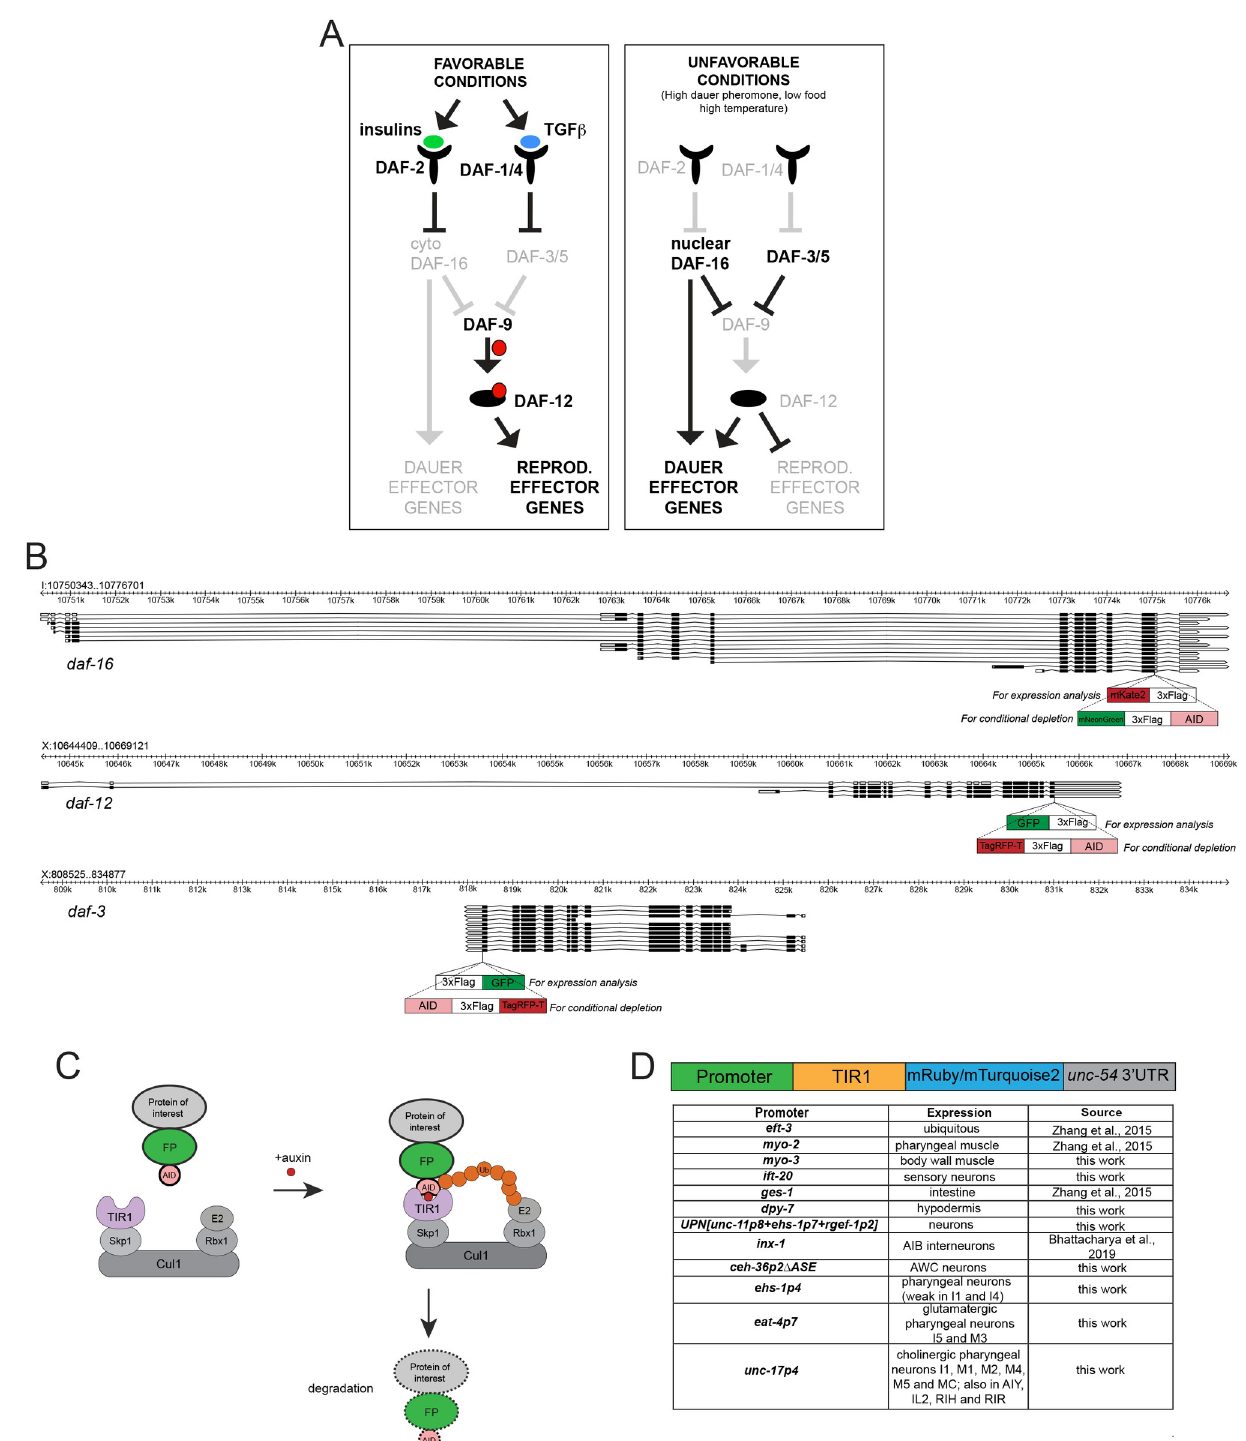
Fig 1. Reagents generated for this study. ( A ) Much simplified overview of the dauer pathways, with DAF-3/SMAD, DAF-16/FoxO, and DAF-12/VDR as transcriptional effectors [25]. ( B ) Genomic loci of daf-16 , daf-12 , and daf-3 . The insertions sites and schematics of the expression reporters and of the AID tag are shown. ( C ) Schematic of the AID system. Skp1, Cul1, Rbx1, and E2 are phylogenetically conserved components of the E3 ligase complex. TIR1 is a plant-specific substrate-recognizing subunit of the E3 ligase complex. AID, fused to a protein of interest, is bound by TIR1 in the presence of auxin, which leads to ubiquitination and proteasomal degradation of the protein of interest. ( D ) Summary of TIR1 transgenes utilized in this study. See Materials and methods for details on TIR constructs [11,37–40]. AID, auxin-inducible degron.